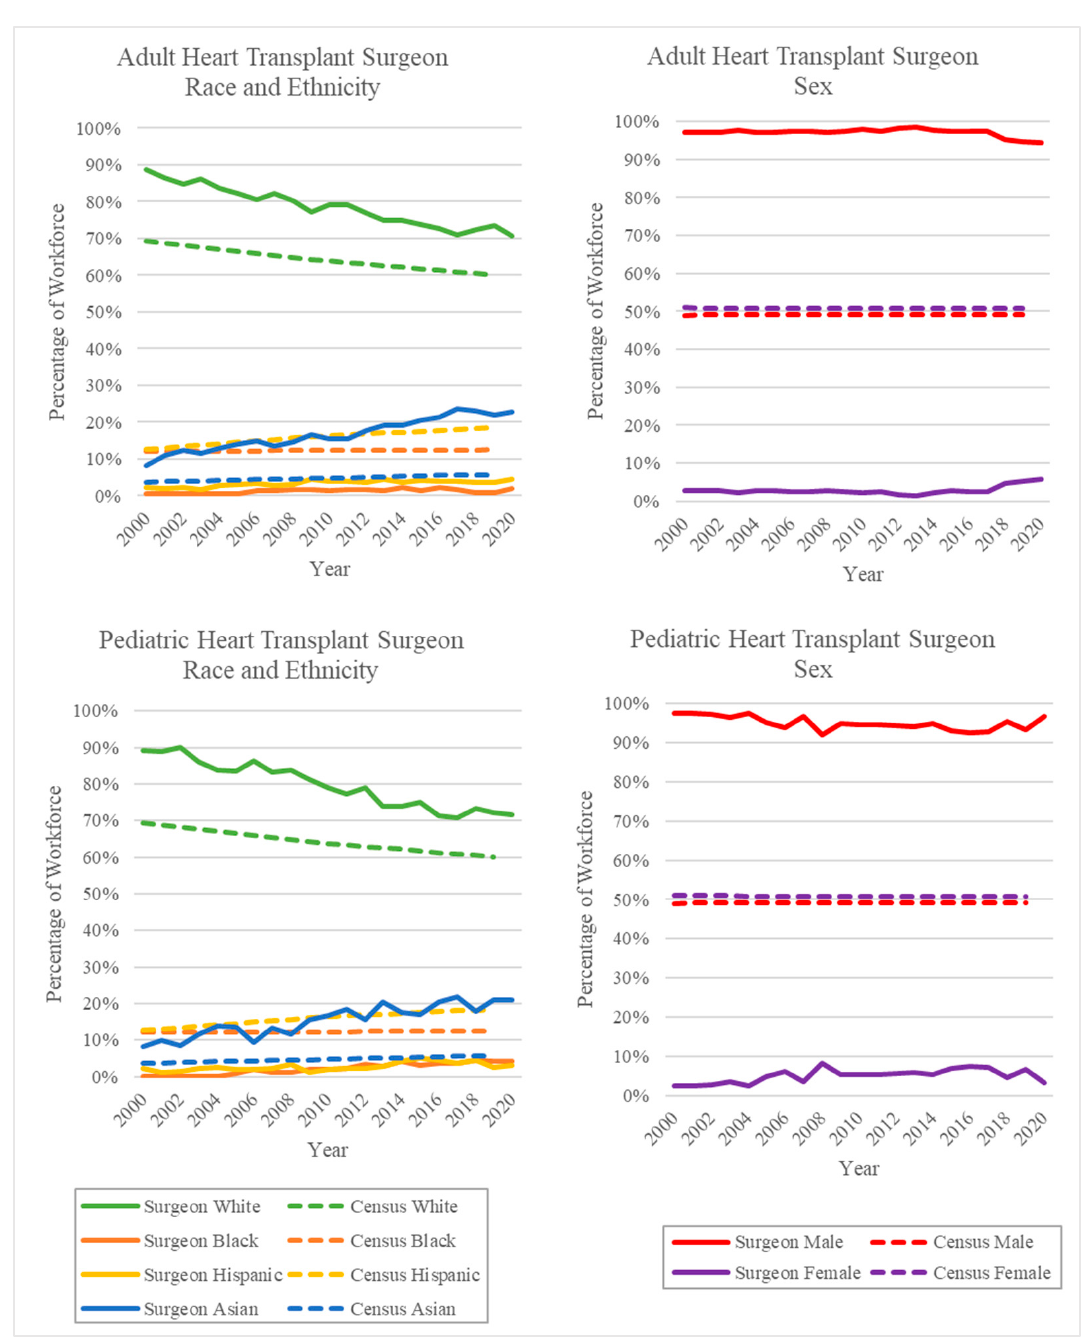
Figure 1. Percentage of workforce by year of surgeons performing at least one HTx. Solid lines represent the HTx surgeon workforce percentage, and dashed lines represent the US population percentages as reported by the US Census [11,12].